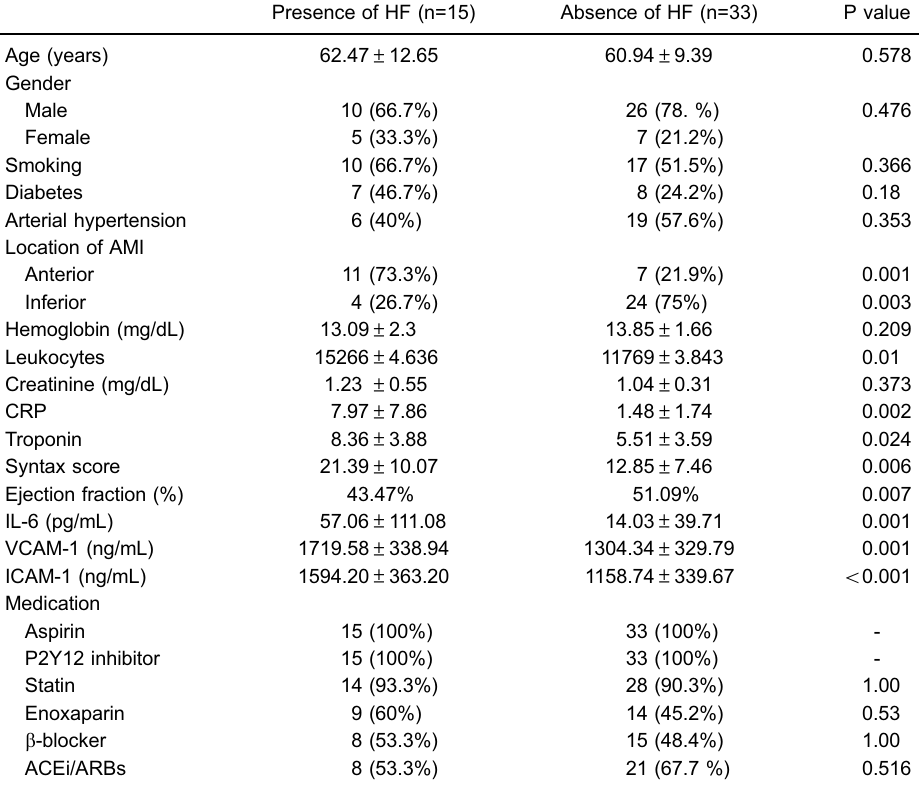
Table 1. Clinical and laboratory characteristics of the patients according to the presence or absence of post-acute myocardial infarction new heart failure (HF). Presence of HF